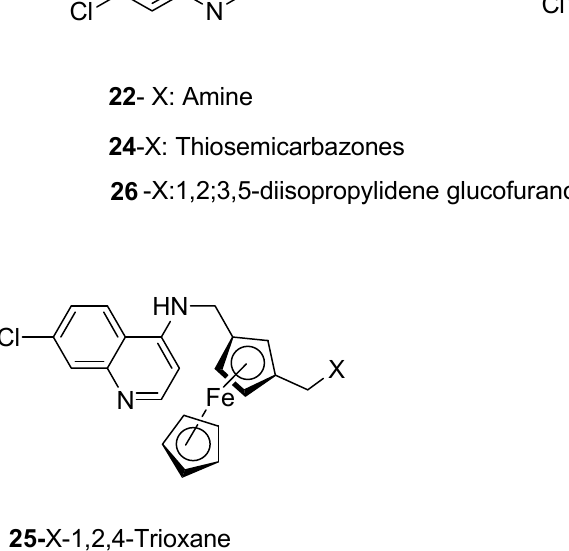
Figure 5. Quinoline-trioxolanes hybrid compounds. 4.4. Hybrid Compounds Containing Quinoline Derivatives and Antibacterial Agents Quinoline-antibiotics have been developed using different antibacterial agents such as cinnamic acid. Hybrid compounds 31 containing a 4-amino-7-chloroquinoline and cinnamoyl scaffolds linked via an alkylamine chain have been reported to be a potent antimalarial in vitro (Figure 6) [51]. Hybrid compounds containing an aminobutyl chain were highly active against erythrocytic P. falciparum parasites [51]. Hybrid compounds 32 containing 4-aminoquinoline- and clotrimazole-based pharmacophores have been reported. The compounds interacted with free heme and Plasmodium falciparum heme metabolism. The compounds were effective in vitro against chloroquine-sensitive and -resistant Plasmodium falciparum strains. Some of the compounds were effective in vivo against P.